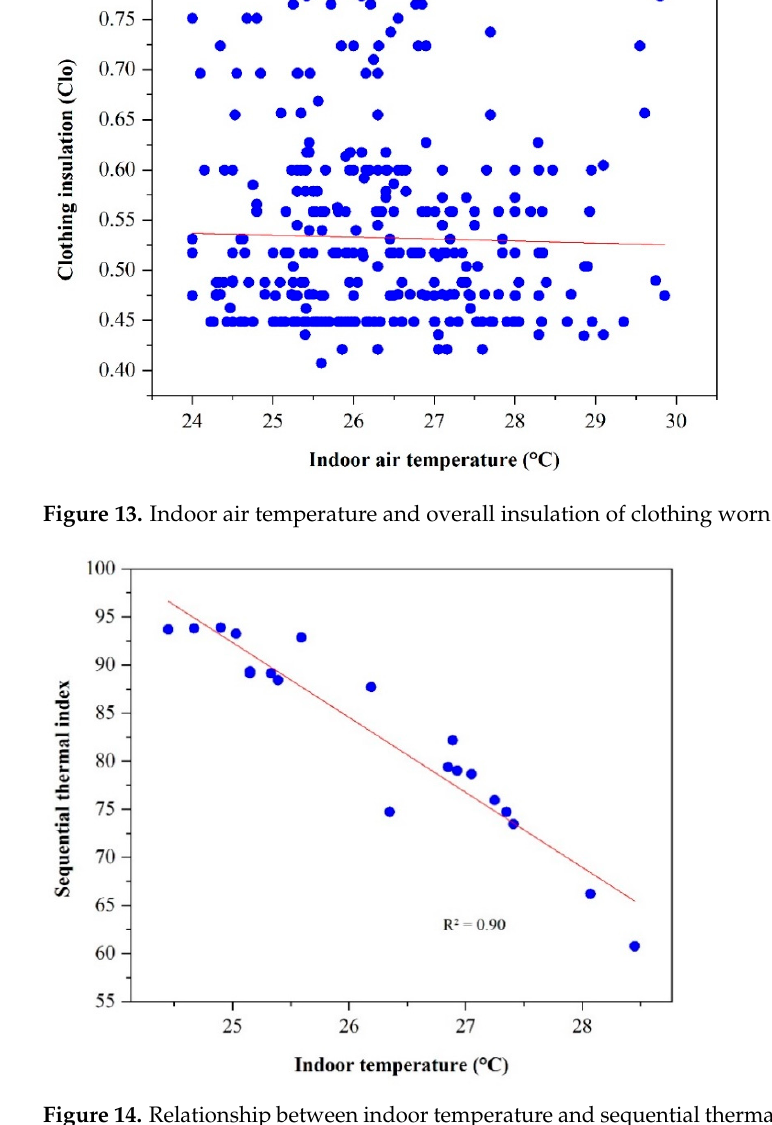
Figure 14. Relationship between indoor temperature and sequential thermal index in APEI build- ings.